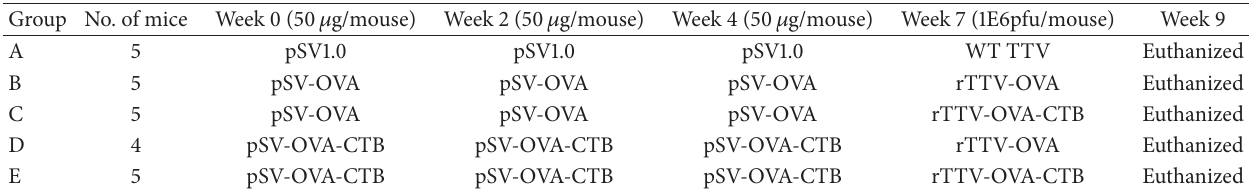
Table 1: Mice immunization